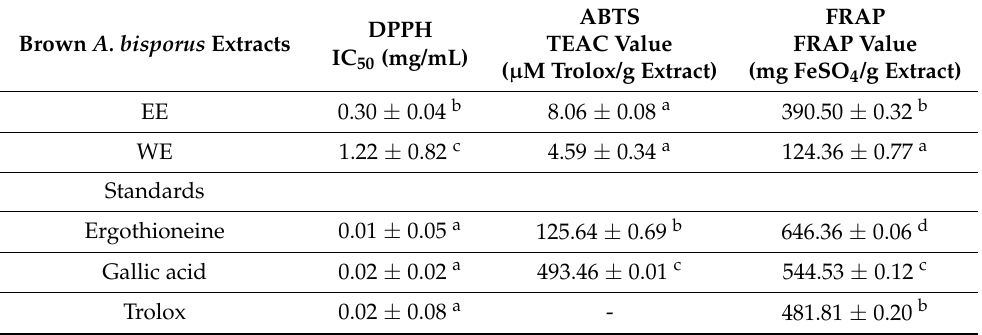
Table 3. Antioxidant activity of brown A. bisporus extracts and standards by DPPH, ABTS, and FRAP